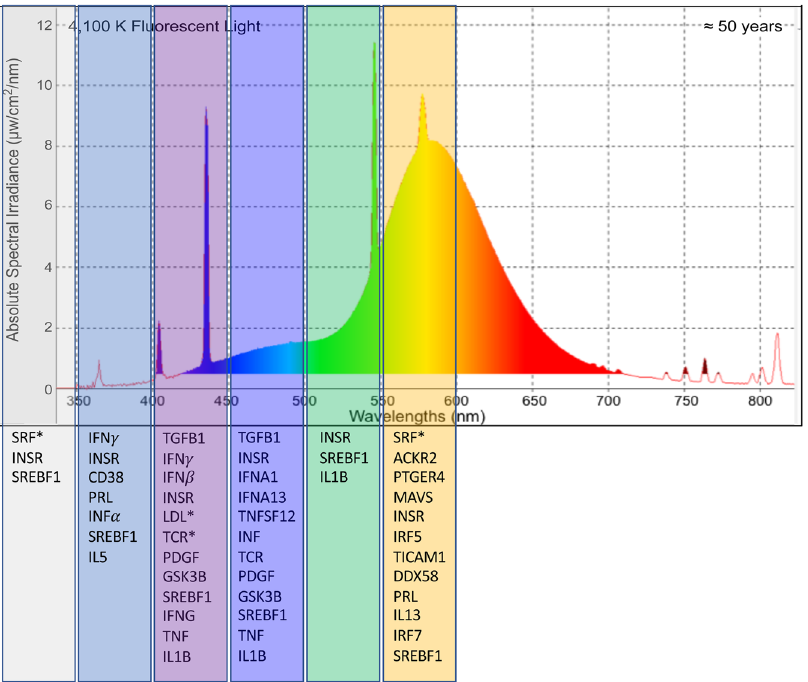
Figure 4. Upstream regulators modulated by discrete 50 nm wavebands that are also modulated by FL. Genes with an * are oppositely modulated following 50 nm exposure compared to the complex FL exposure. We observed both light responsive gene expression (ie. genes modulated in response to all light stimuli; INSR and SREBF1 ) and waveband specific gene expression (ie. genes modulated in response to only discrete wavelengths).